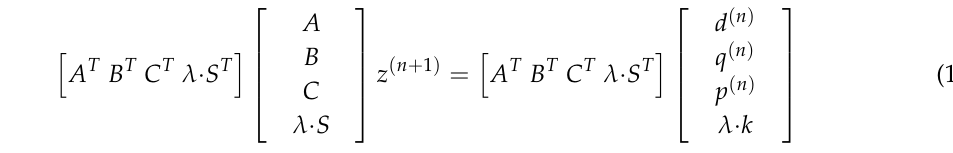
Figure 8. Approximate XCO 2 surface in the flight test area.